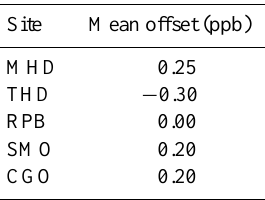
Table 5. Calibration offsets relative to the NOAA2006A